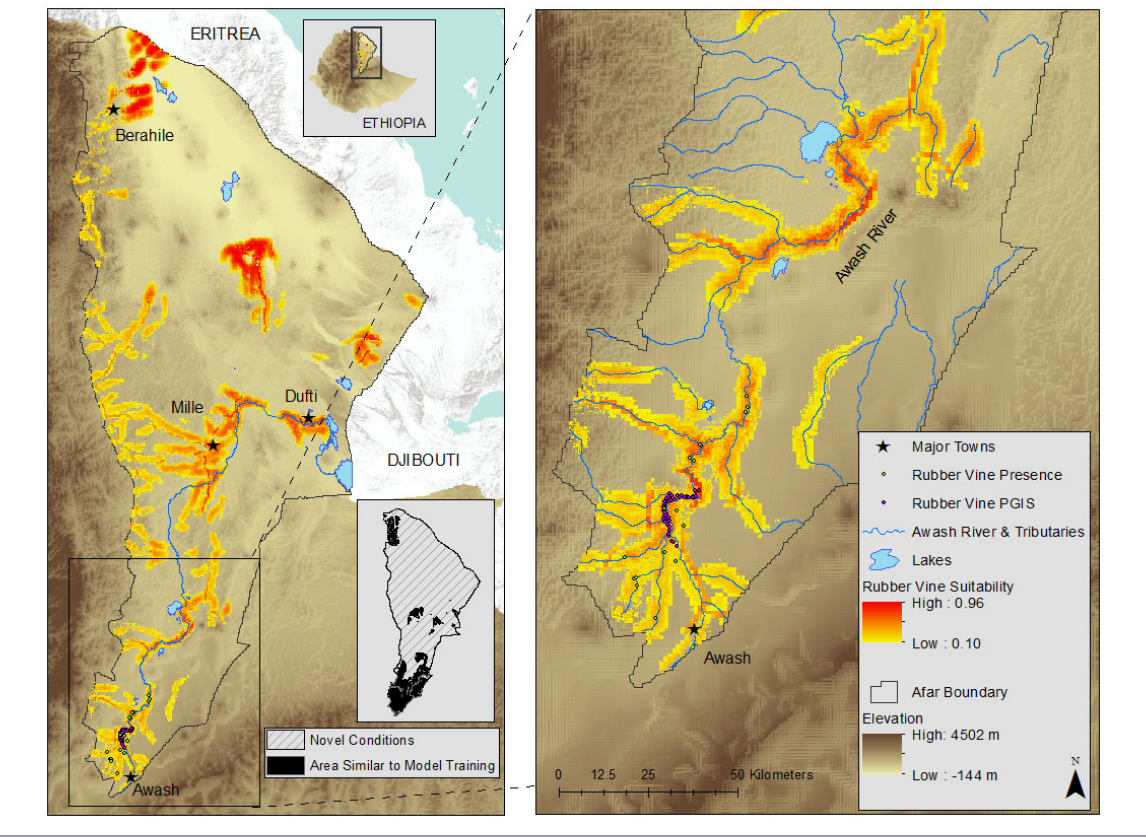
Fig. 4 . Rubber vine ( C. grandiflora ) habitat suitability across the Afar region of Ethiopia. Areas in red denote predictions of high habitat suitability. Diagonal lines on the Multivariate Environmental Similarity Surface map inset signify locations with novel environmental